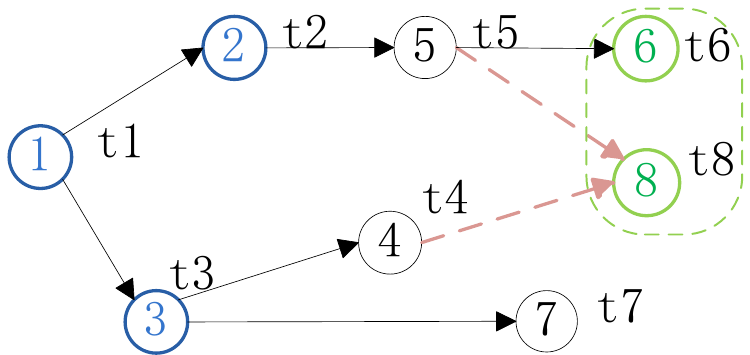
Figure 2. Diagram showing the processing constraint matrix.